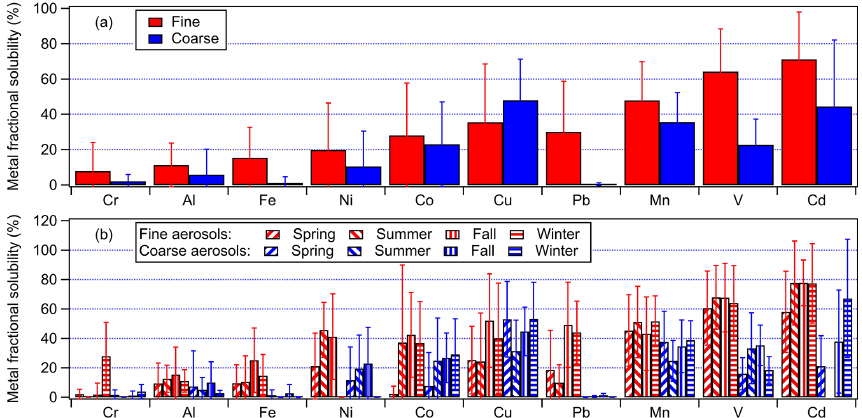
Figure 4. (a) Study-averaged fractional solubilities of metals in fine and coarse aerosols. (b) Seasonal average fractional solubilities of metals in fine and coarse aerosols. The error bars represent 1 standard